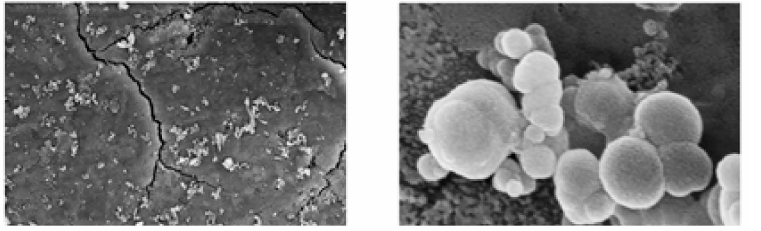
Figure 9. SEM micrographs of geopolymer samples soaked in simulated body fluid show the formation of some globular hydroxyapatite crystals